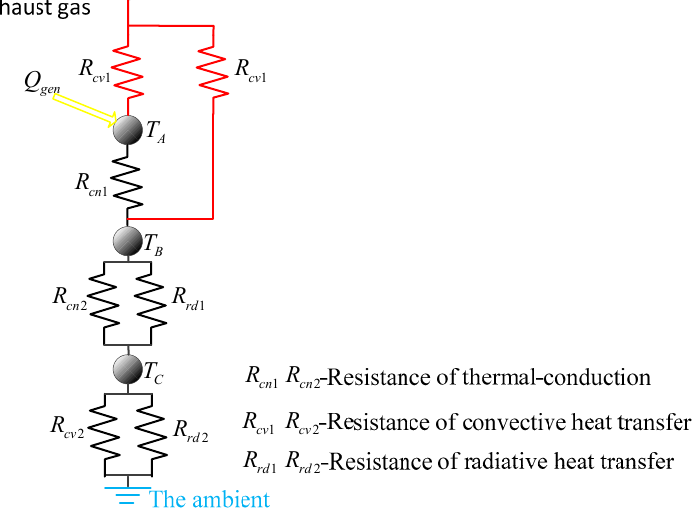
Figure 8. Thermal network representing the catalyst and associated thermal elements.